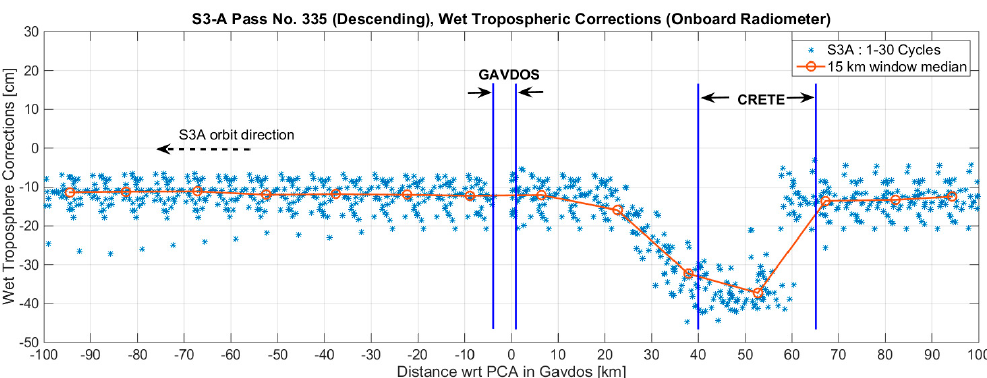
Figure 16. Profiles of Zenith Wet Troposphere Corrections in cm, as observed by the S3A radiometer for cycles 1–30, along the descending Pass No.335, starting off north of Crete and converging south onto the Gavdos Cal/Val site (Please see Figure 12, S3A descending Pass No.335, right mage).